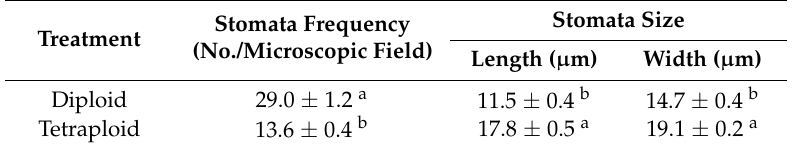
Table 3. Effect of polyploidy on characteristics of stomata in Salvia miltiorrhiza.